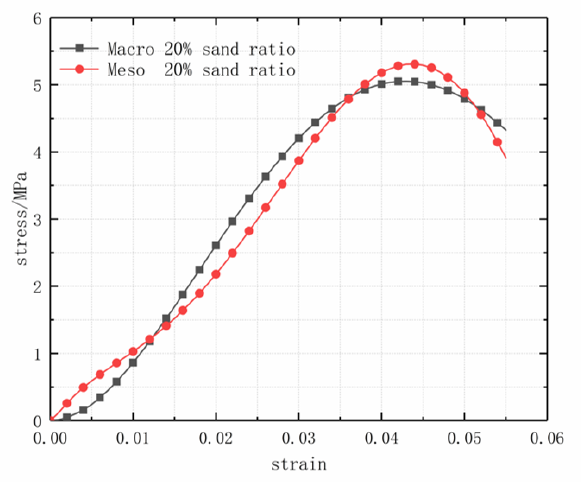
Figure 2: Analysis of parameters inversion